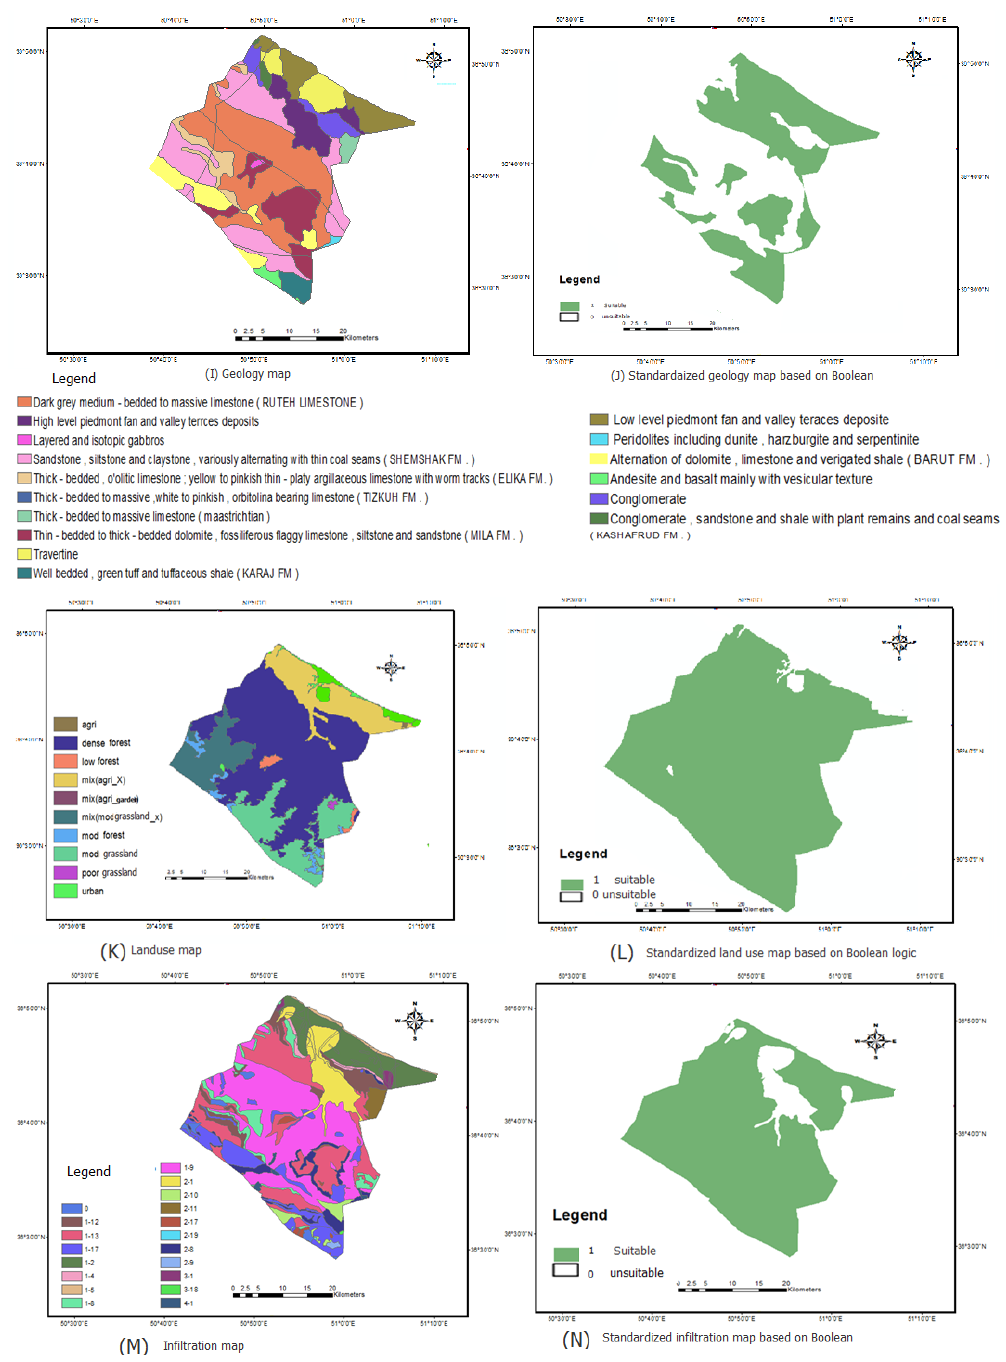
Figure 5. The factor map layers used in the regional screening method and standardized maps based on Boolean